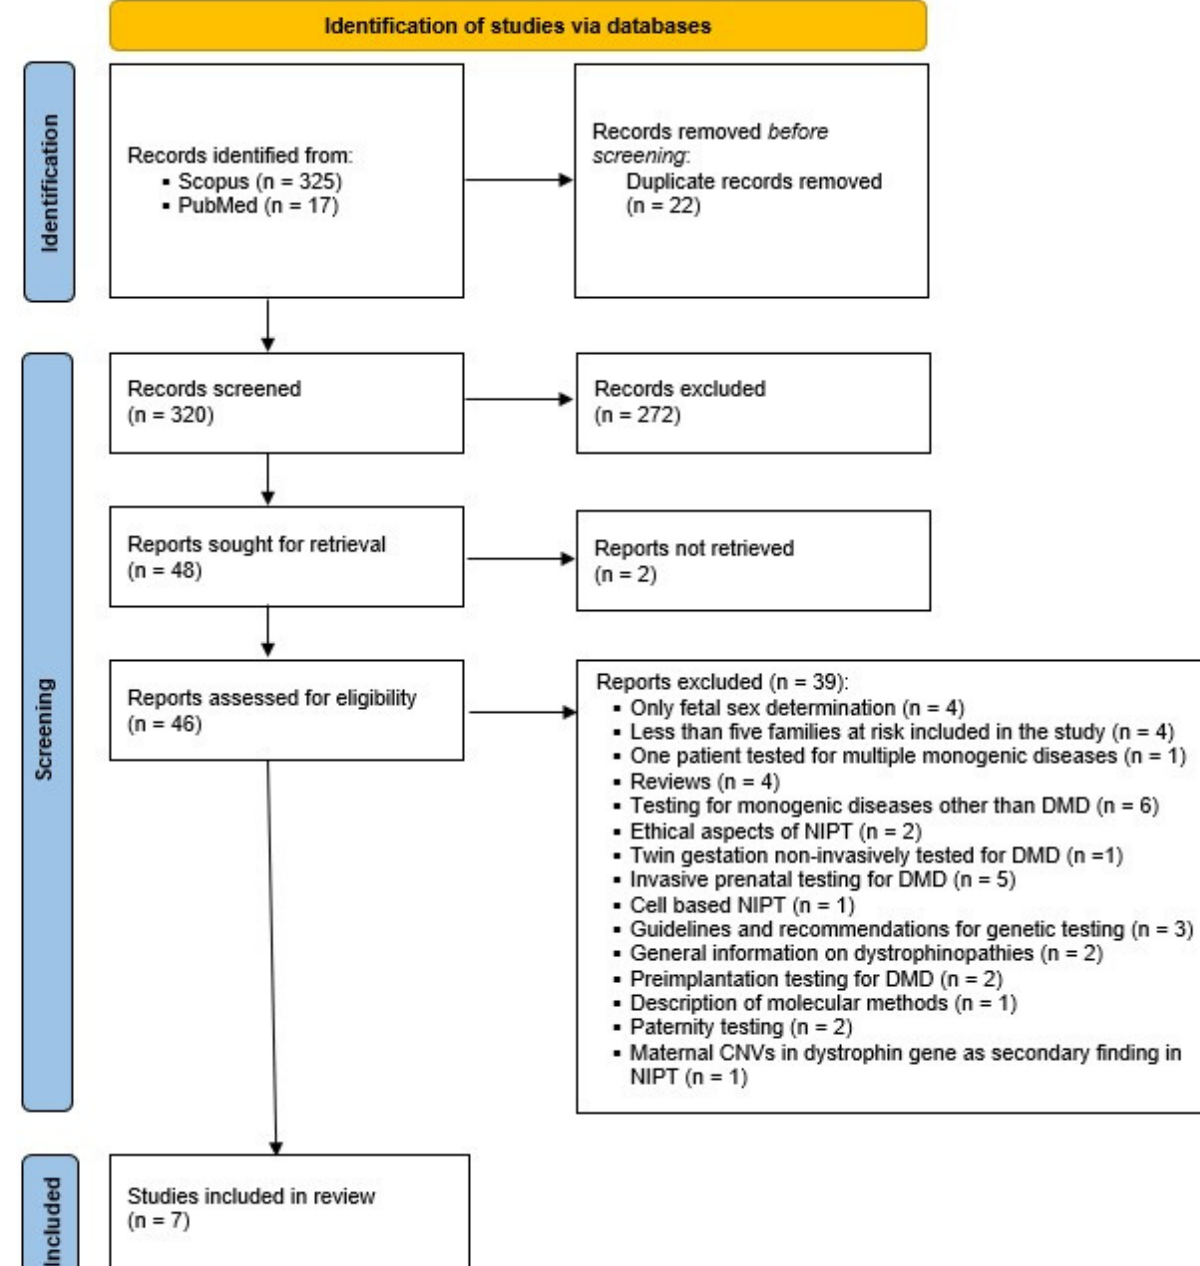
Figure 1. PRISMA flow diagram.